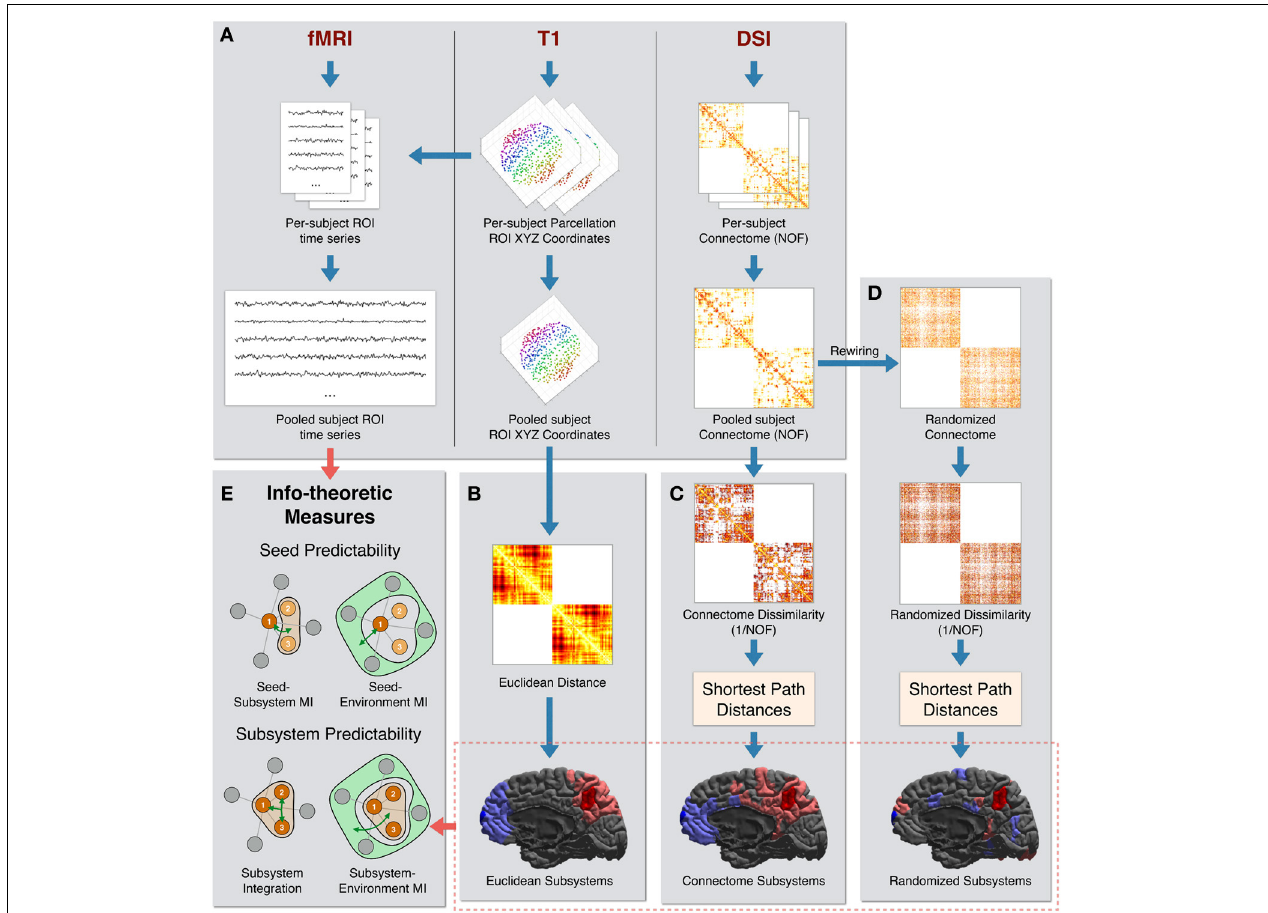
FIGURE 1 | Data processing pipeline. (A) The steps used to create the final dataset of pooled subject ROI time series, pooled subject ROIs coordinates, and pooled connectome [using the number of fibers (NOF) measure]. (B) Euclidean Distance is computed as the physical distance between the centroids of ROI coordinates. At bottom are shown two example Euclidean sets of size 20 ROIs centered on two “seed” ROIs: one seed in the precuneus region (seed in dark red and the rest of the subsystem in light red) and one seed in the frontal pole region (seed in dark blue and the rest of the subsystem in light blue). (C) NOF structural connectivity matrix is transformed into a Connectome Dissimilarity matrix. Shortest paths on the